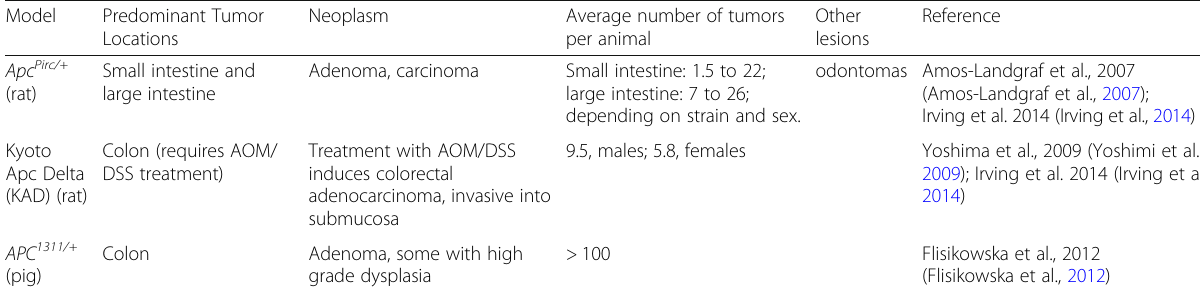
Table 2 Apc -related models, other species